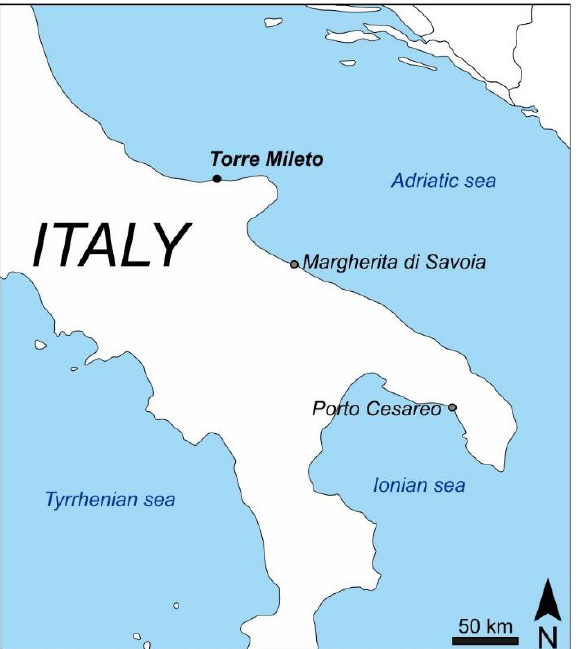
Figure 1. Sampling area. At Torre Mileto, reef fragments and incoherent sands were sampled. In Margherita di Savoia and Porto Cesareo, the sands were collected to carry out the experiments. The sampling was carried out underwater by collecting portions of the reef with live polychaetes. The samples were collected during seasonal bioconstruction monitoring [16] in areas where the growth was highest, using the same procedures proposed by